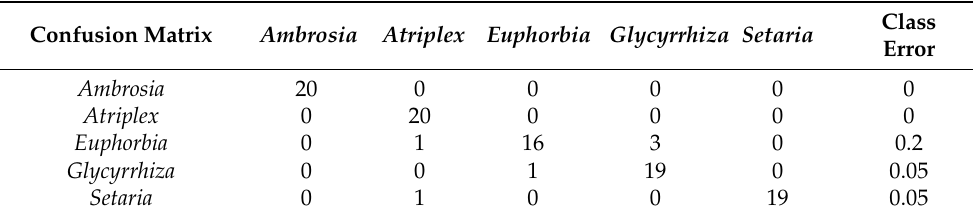
Table 13. Confusion matrix for weed identification, 80